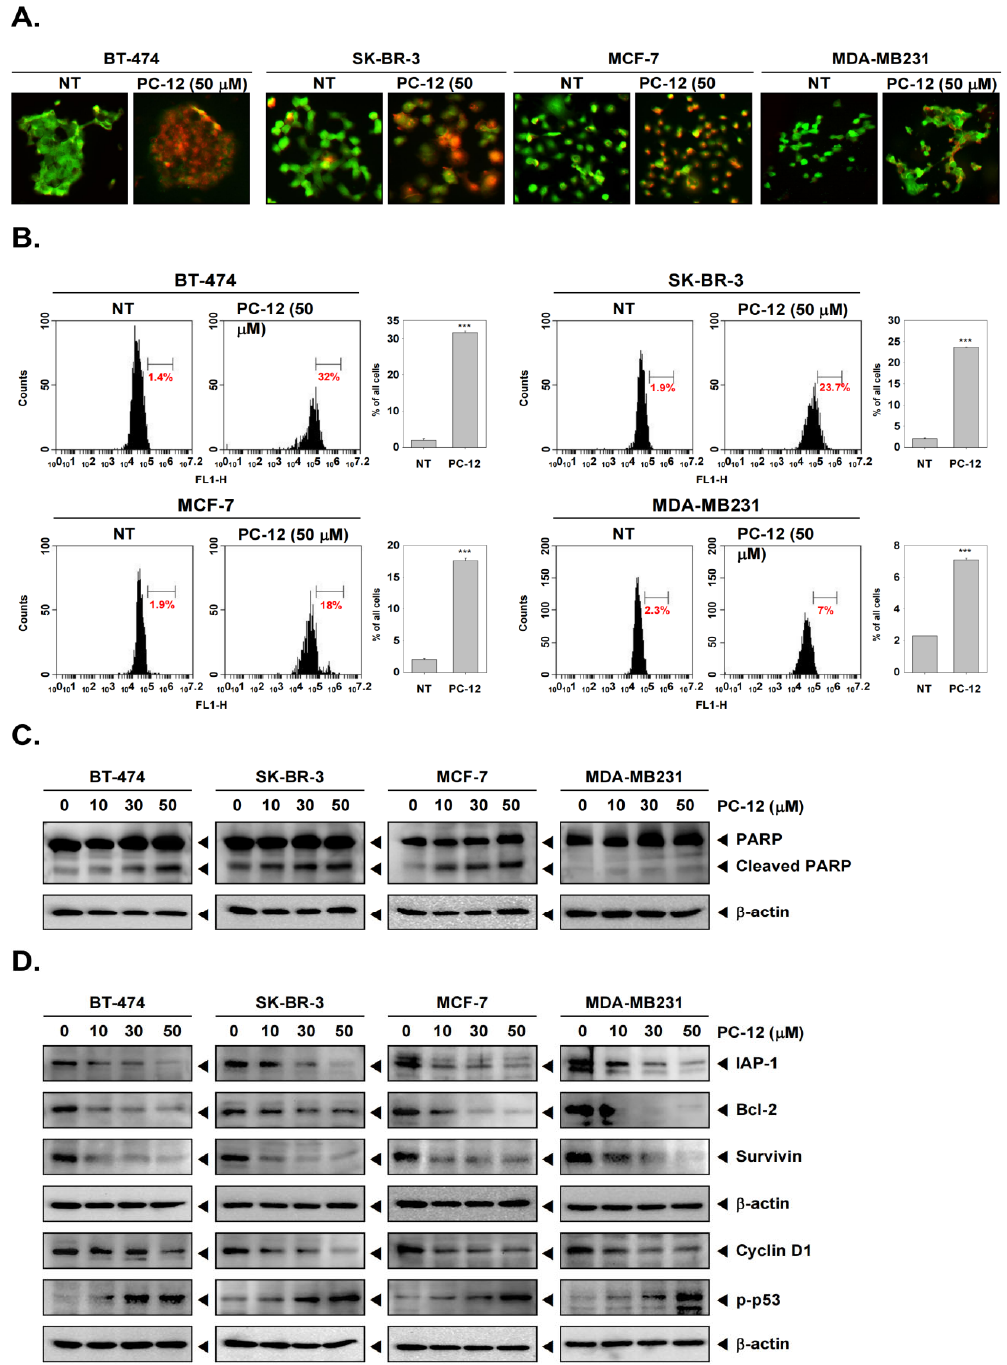
Figure 3. PC-12 produced DNA damage and modulated proteins related to apoptosis and